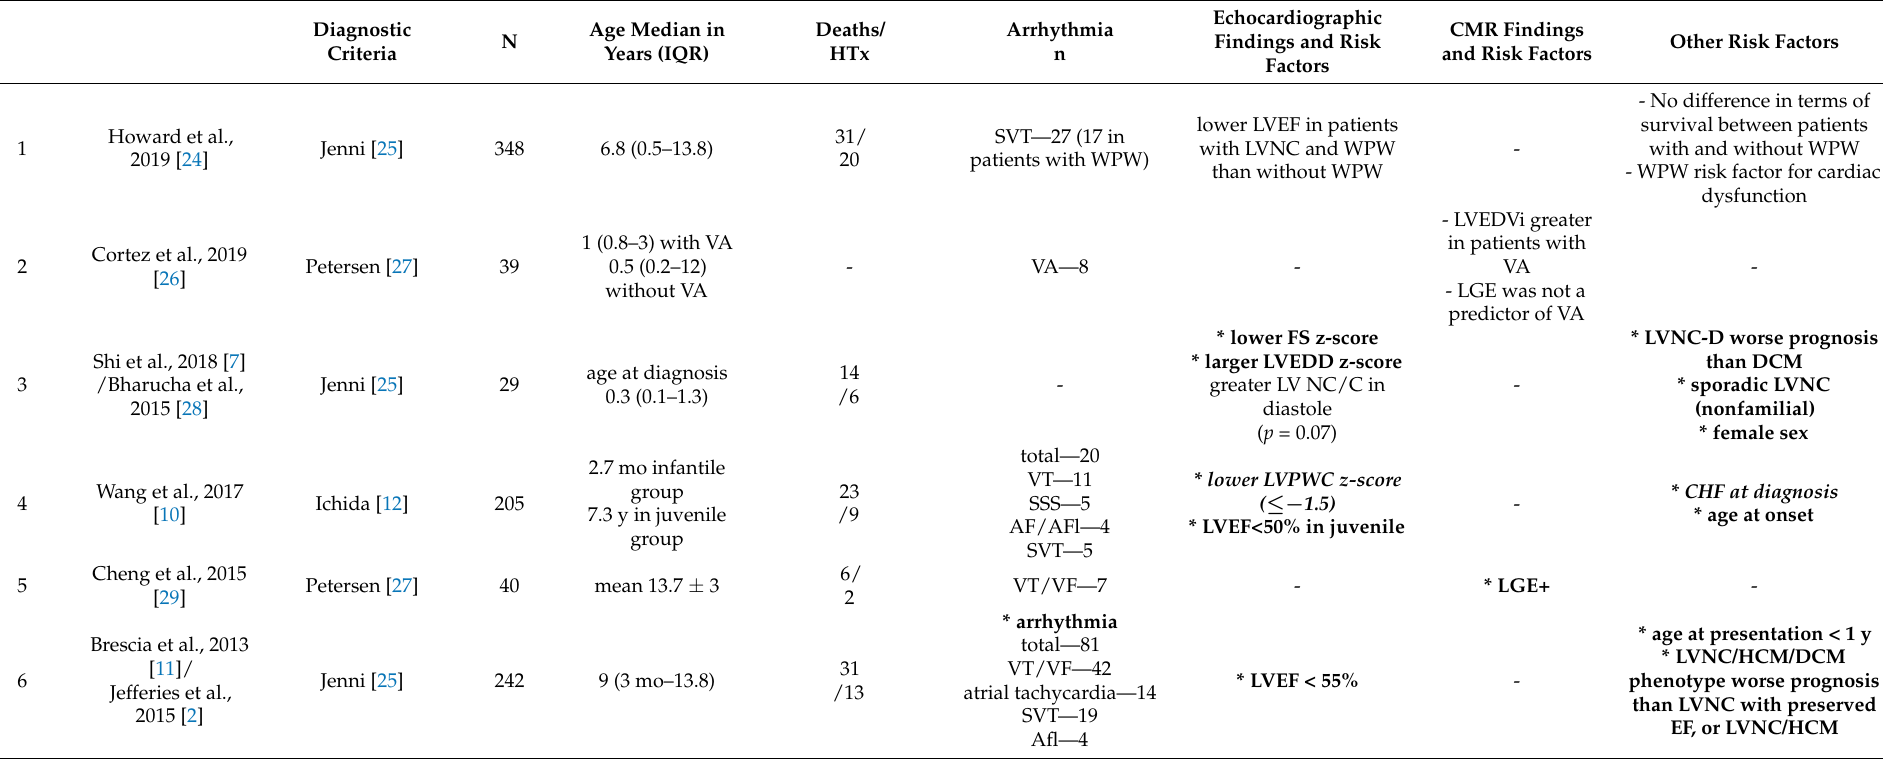
Table 1. Characteristics of patients without congenital heart diseases, as well as echocardiographic, CMR, and other risk factors for unfavorable